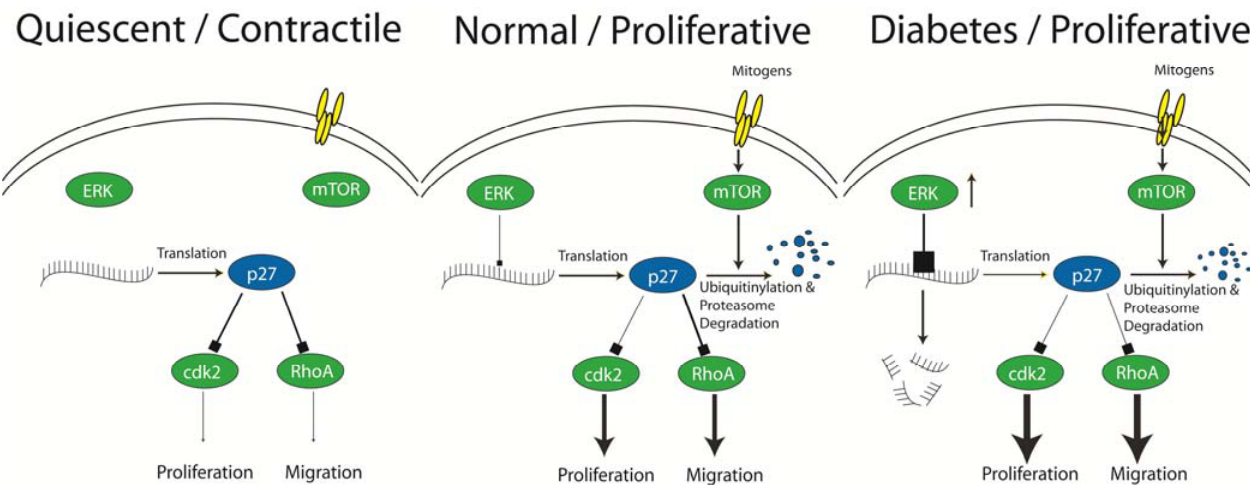
Figure 1. Under quiescent conditions, p27 Kip1 levels are high inhibiting cdk2 and RhoA activity thereby blocking VSMC proliferation and migration (Left Panel). In normal VSMCs, mitogenic stimulation promotes the proteasome dependent degradation of p27 Kip1 protein through, at least in part, activation of the mTOR pathway (Center Panel). Loss of p27 Kip1 permits increased activation of cdk2 and RhoA leading to VSMC proliferation and migration. In the presence of diabetes, ERK activity is increased, which in turn destabilizes p27 Kip1 mRNA (Right Panel). This lowers p27 Kip1 protein levels before mitogenic stimulation occurs, allowing for greater proliferation and migration. Activation of the mTOR pathway functions as it did under normal conditions and will promote down regulation of p27 Kip1 protein as